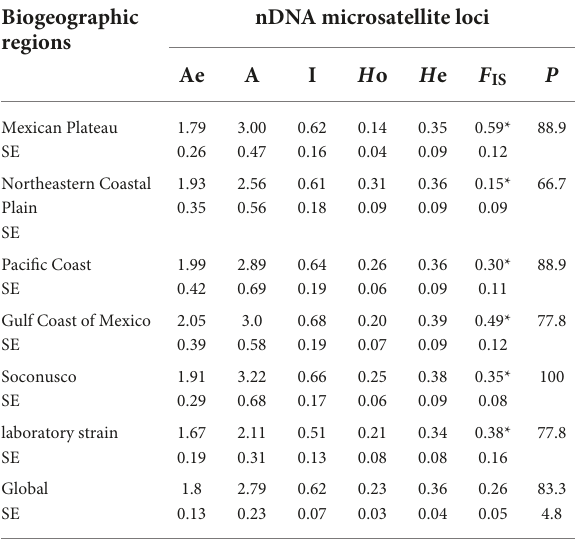
TABLE 1 Genetic diversity of nine nDNA microsatellite loci.